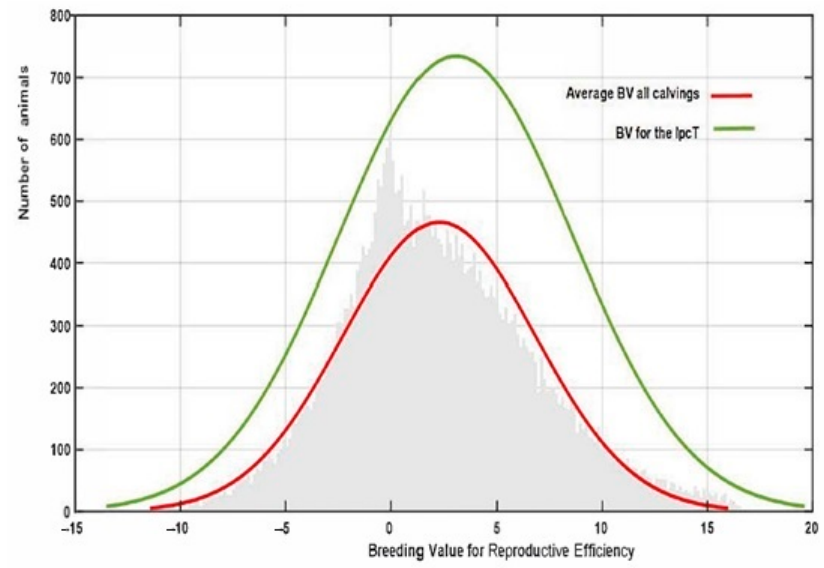
Figure 6. Variation in reproductive efficiency in the whole population estimated using PCA (IpcT) or the average RE EGV for all the calvings. Table 6. Correlations between the estimated EGV1 and the estimated EGV for each calving number and Correlations between the IpcT and the estimated EGV (first 9 calvings only).